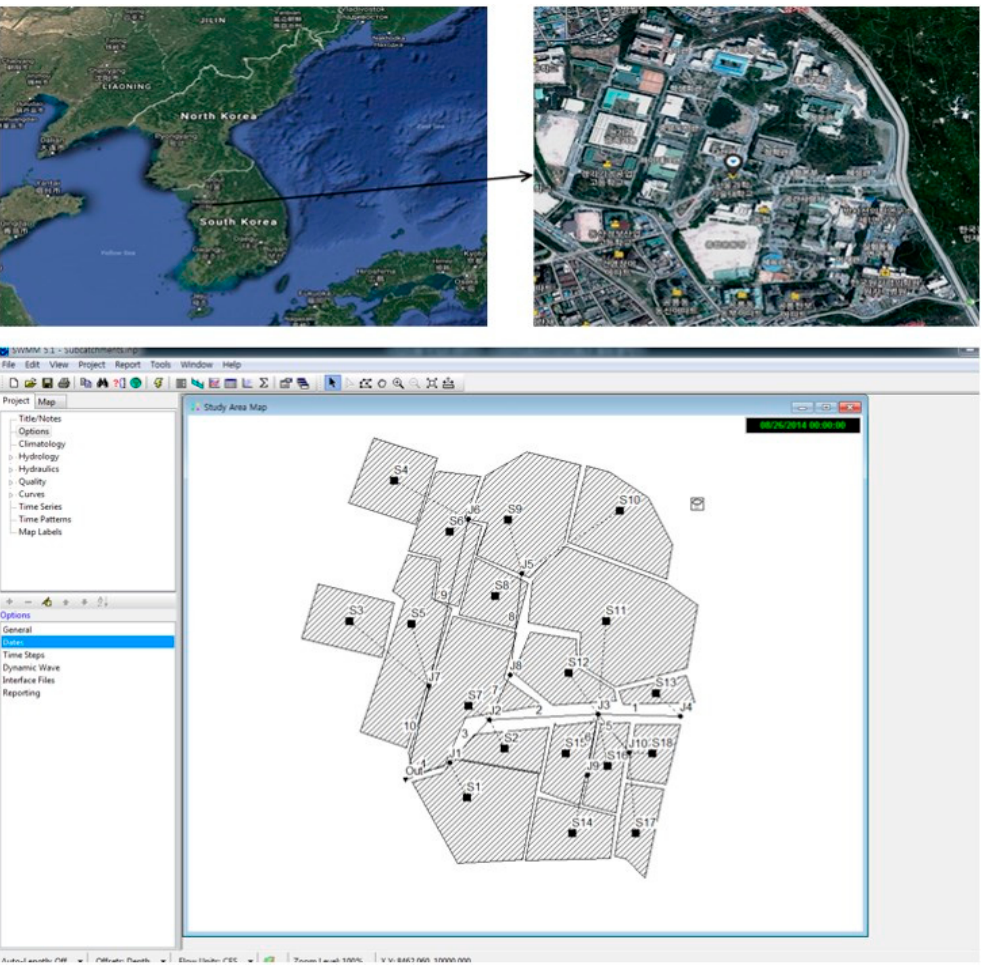
Figure 1. Storm-water management model (SWMM) modeling map of the study area.